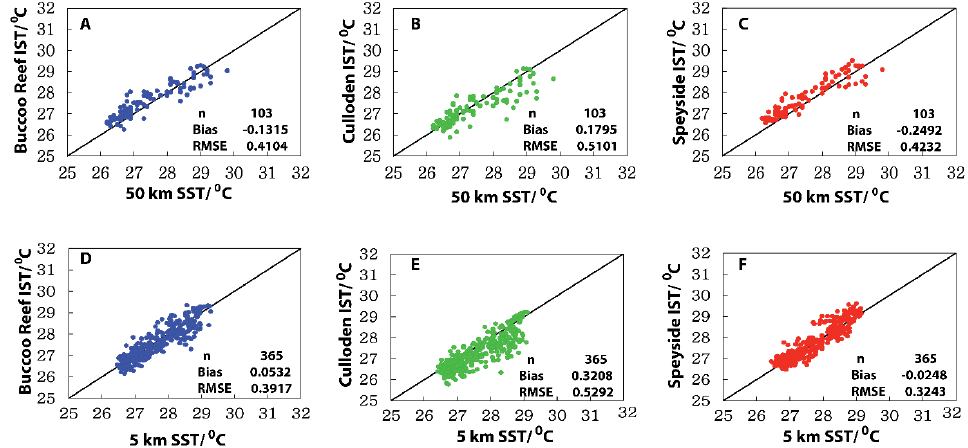
Figure 4. Comparison of 50 km SST ( A – C ) and 5 km SST ( D – F ) with in situ temperature (IST) measurements for 2014 at Buccoo Reef ( A , D ), Culloden ( B , E ) and Speyside ( C , F ), Tobago. The black line is the line of unity. Positive bias indicates SST greater than IST.